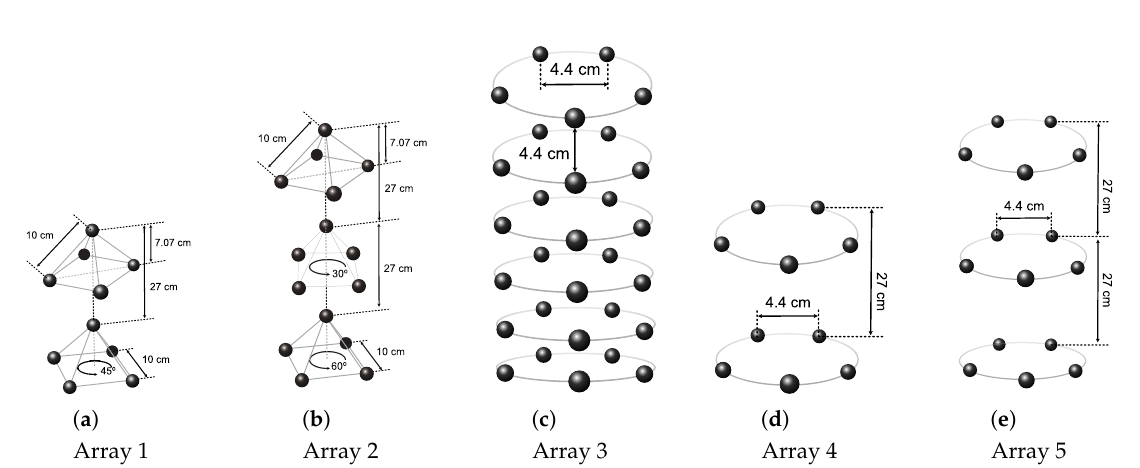
Figure 4. Array topologies considered in this